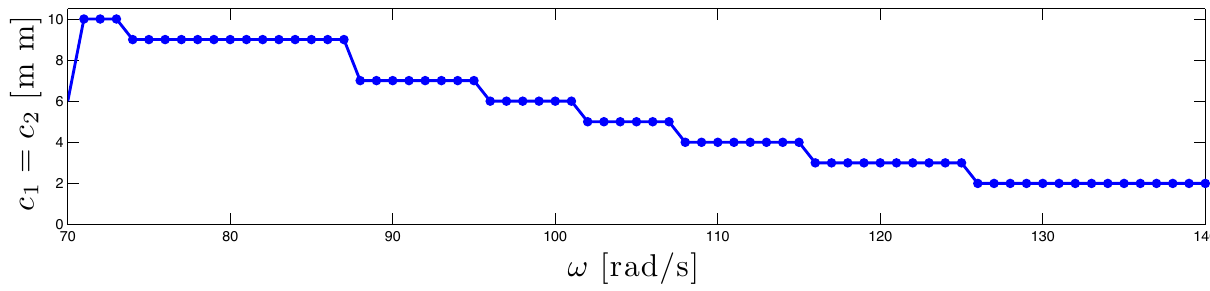
Fig. 10 Black and blue: the dependence of the peak-to-peak vibration amplitude of the rotor frame and impact element, respectively, on angular frequency of excitation of the baseplate for unlimited movement of the impact body; red: the dependence of the peak-to-peak vibration amplitude of the rotor frame on angular frequency of excitation of the baseplate for the movement of the impact body limited by clearances; for parameters m t = 25 kg and b t = 500 N s m − 1 .